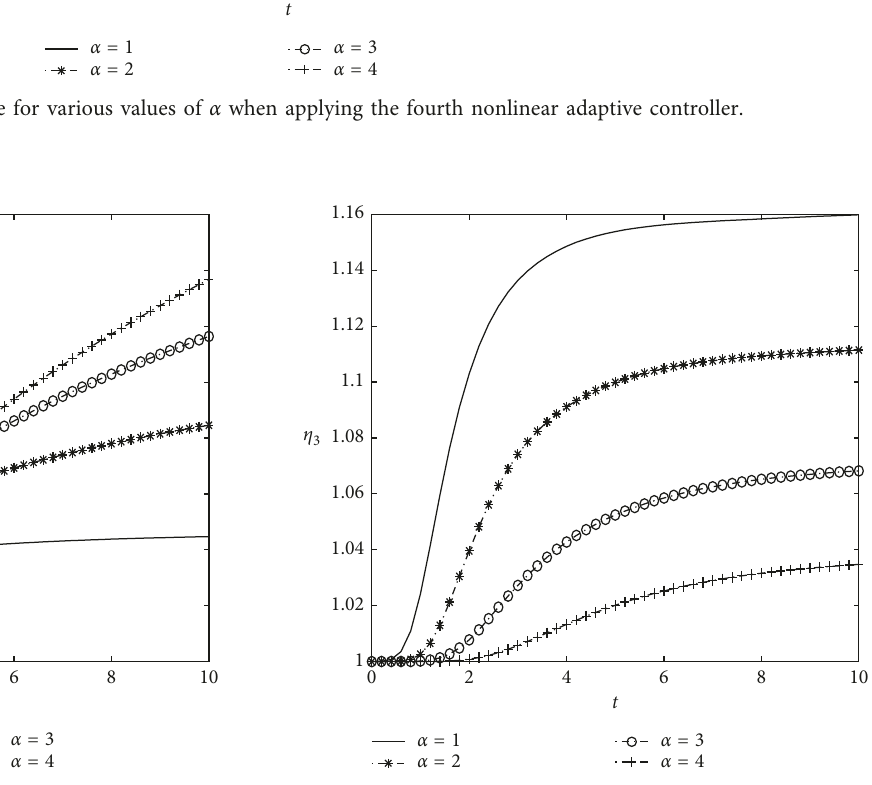
Figure 17: η over time for various values of α when applying the 3 fourth nonlinear adaptive